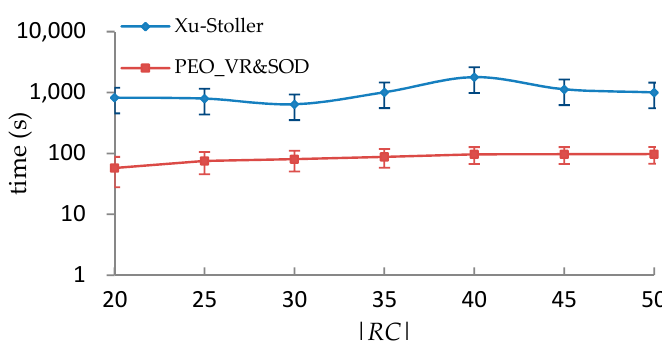
Figure 6. Comparison of time with Xu-Stoller for different | RC | values.